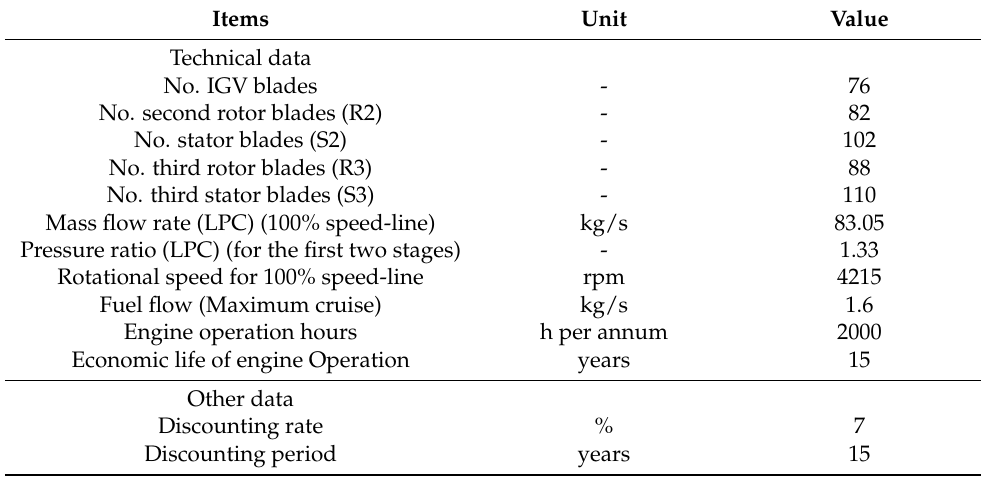
Table 1. Low-pressure compressor (LPC) and the related economic parameters. Reprinted with permission from Refs. [27–30]. Copyright 2013 NASA Technical Report Server